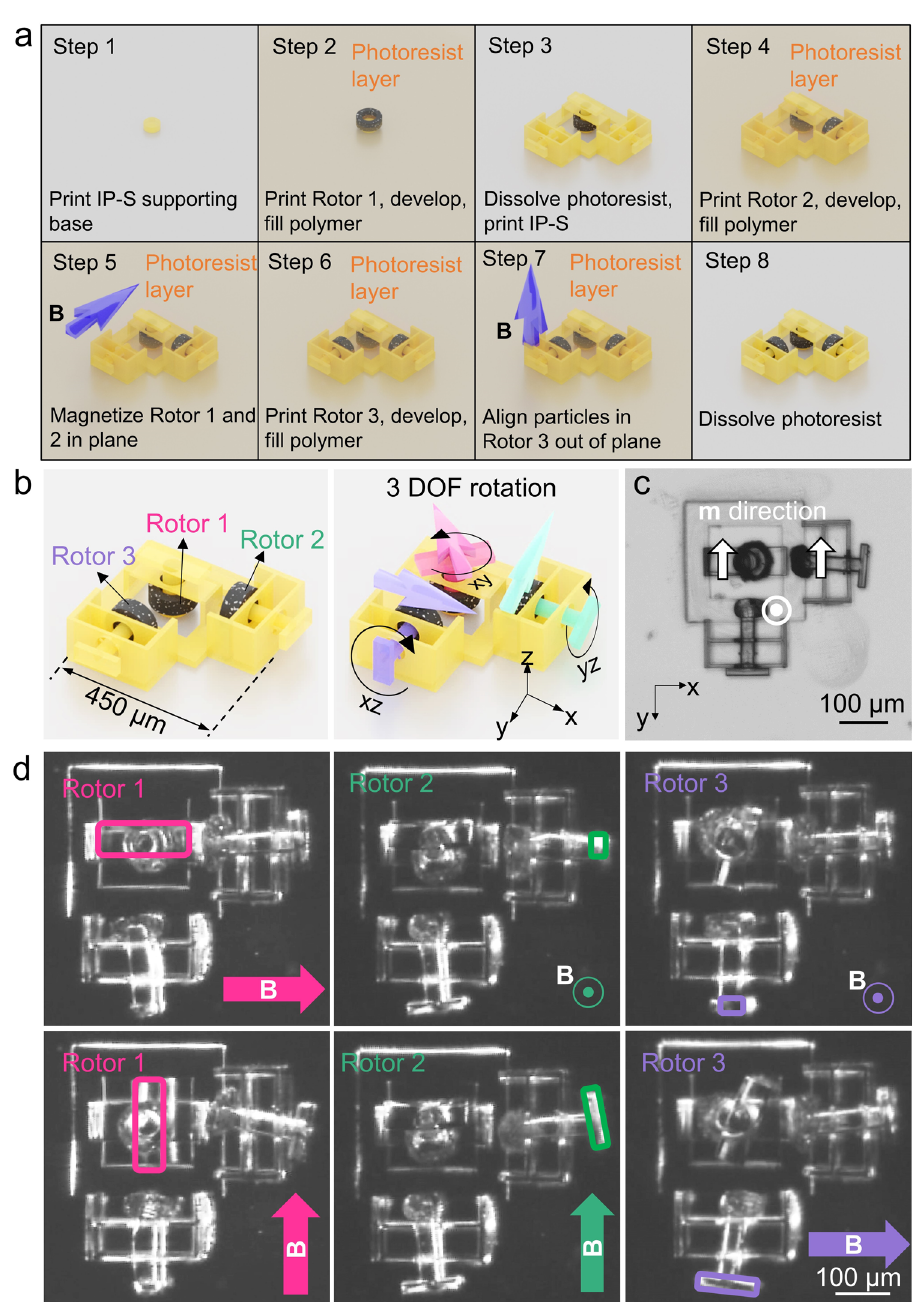
Fig. 4 Multi-DOF rotary system enabled by DLW and micro-molding with multi-step casting and dissolvement. a The fabrication process of the multi- DOF rotary system. b Schematics showing the composition of the system and motions of the three rotor rings. c Microscopic image of this device. The magnetization directions of the three rotor rings are marked with white arrows. d Video (Supplementary Movie 6) frames showing the three-rotor rings can be separately addressed by applying a rotating magnetic fi eld in different planes. The propellers of each rotor are marked with the corresponding colors. The magnetic fi eld is 15 mT rotating at 0.8